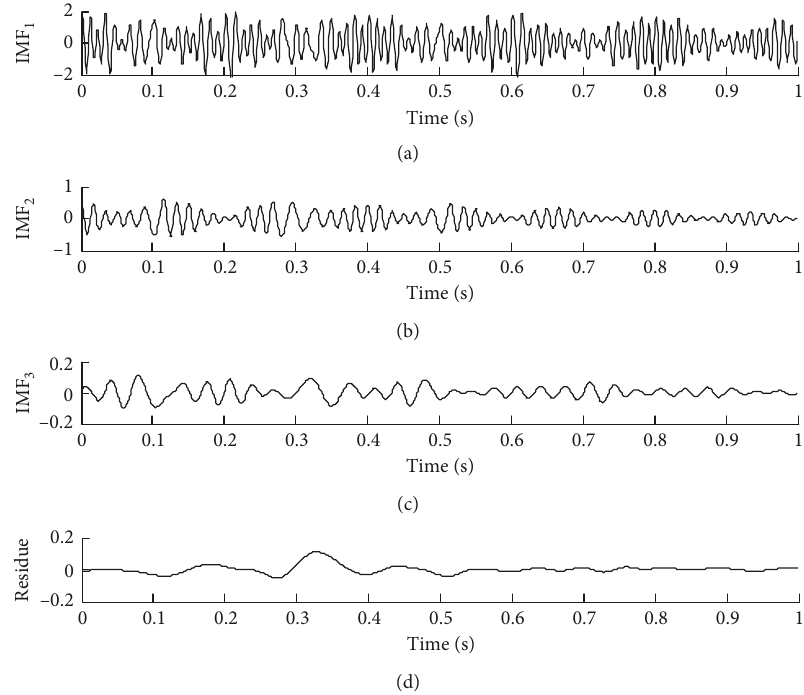
Figure 5: The decomposition results of x Table 1: Evaluating parameters of the components of x